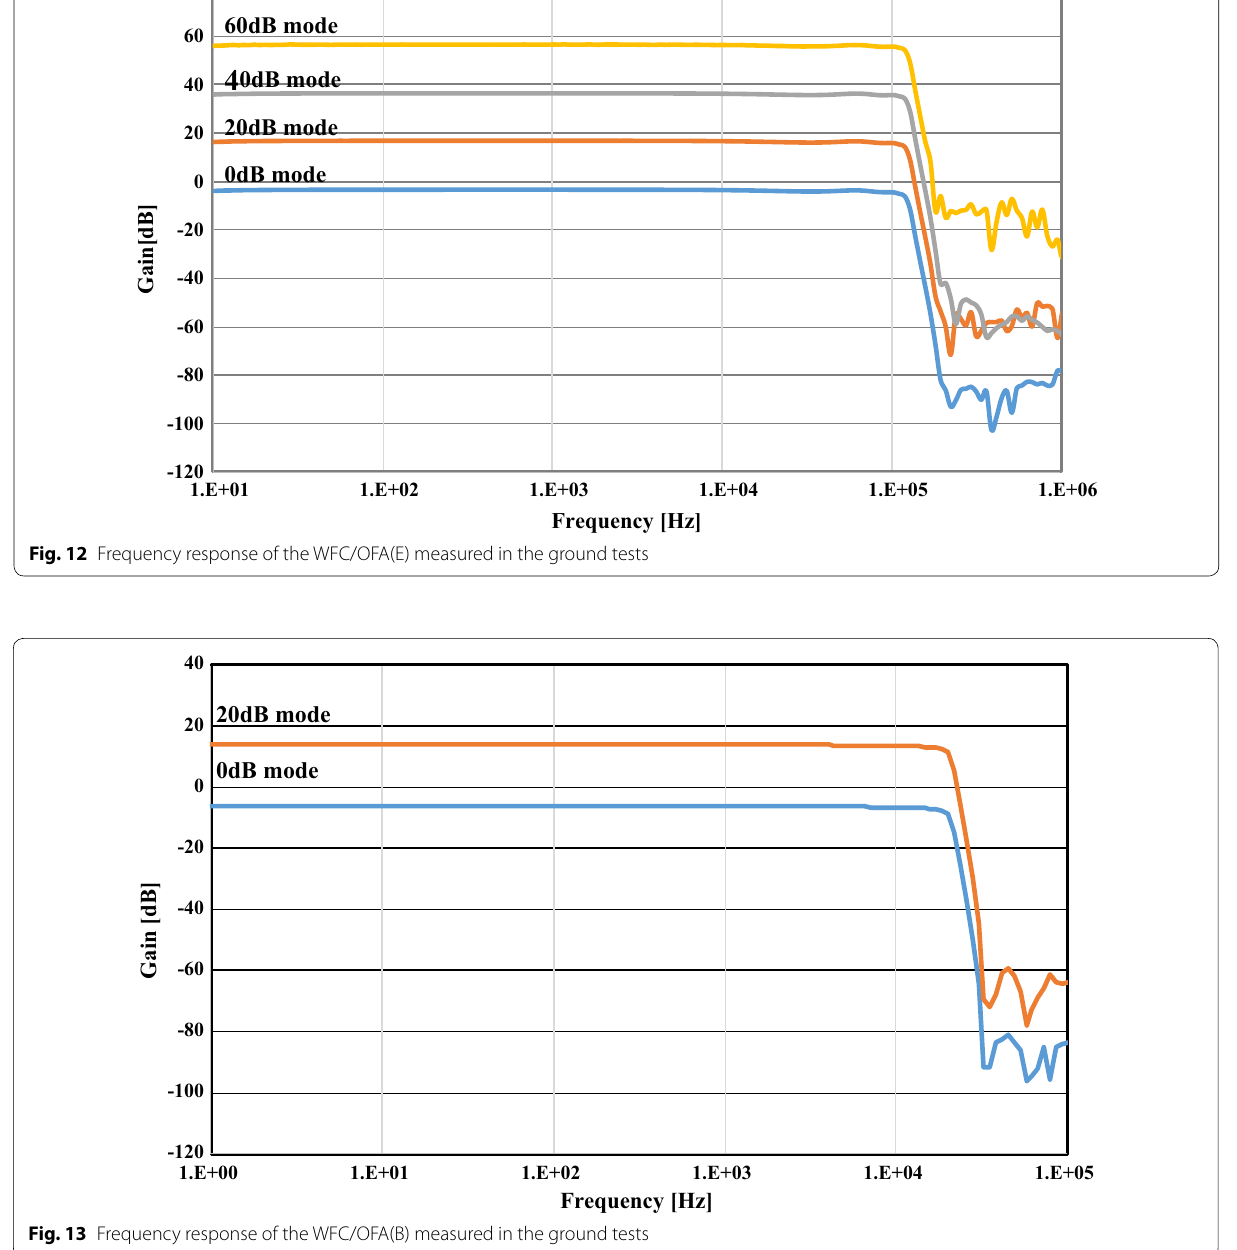
(FFT) is directly applied to the 2048 digital waveform data points. In the 1-MHz mode, a cascade integrator- comb (CIC) filter with a passband below 1 MHz and decimation are applied to the signal from A/D converter, resulting in waveform data at 2.5 mega-samples per sec- ond (MSPS). FFT is applied to the 2048 points of the 2.5 MSPS waveform. Detailed specifications including a